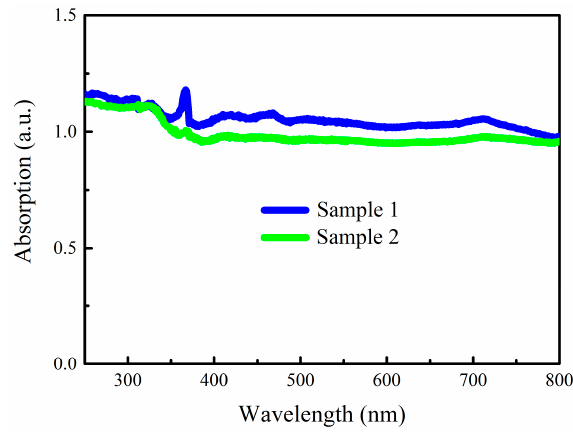
Figure 4. UV-Vis spectra of the as-synthesized samples.